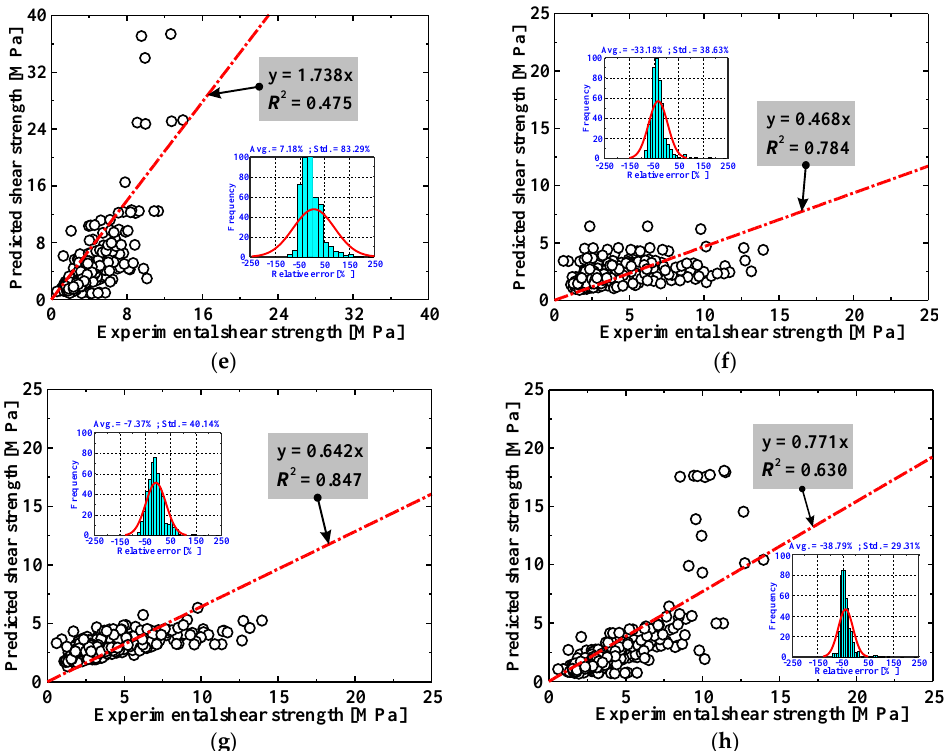
Figure 1. Comparisons between test results and empirical model predictions. ( a ) CECS38-2004 [41], ( b ) DAfStB-2012 [42], ( c ) fib -2010 [43], ( d ) Greenough and Nehdi [44], ( e ) Imam et al. [45], ( f ) Kuntia et al. [46], ( g ) Sharma [47], ( h ) Yakoub [48].